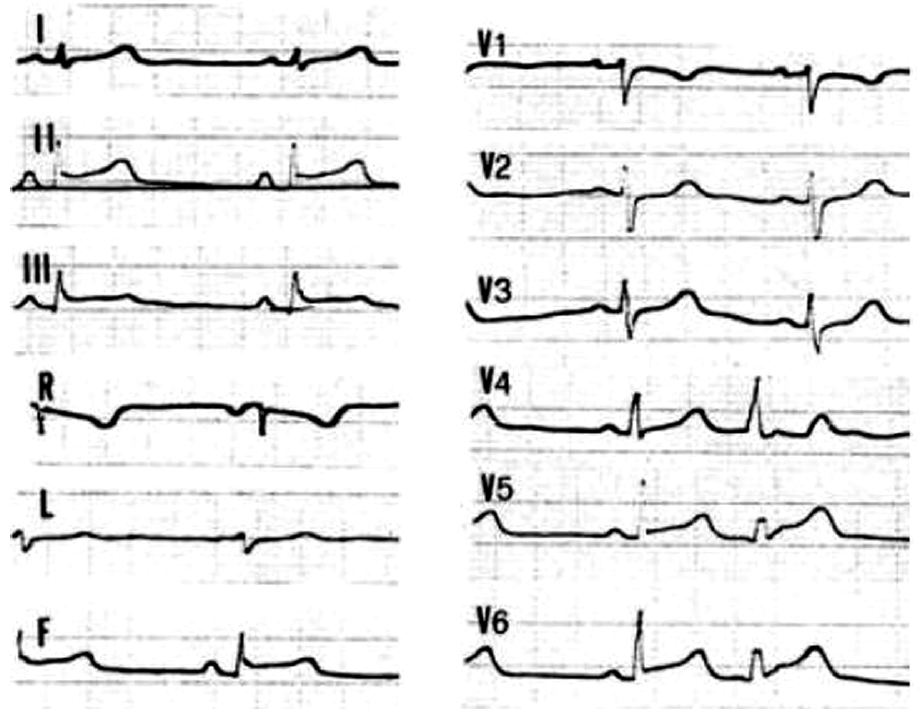
Figure 3. ECG of a 17-year-old female patient during a hot-phase episode. Note the presence of ST segment elevation in inferior and lateral leads. The patient belongs to an ACM family and carries a DSP genetic variant. Reproduced with permission from Bauce et al., European Heart Journal 2005 [7].